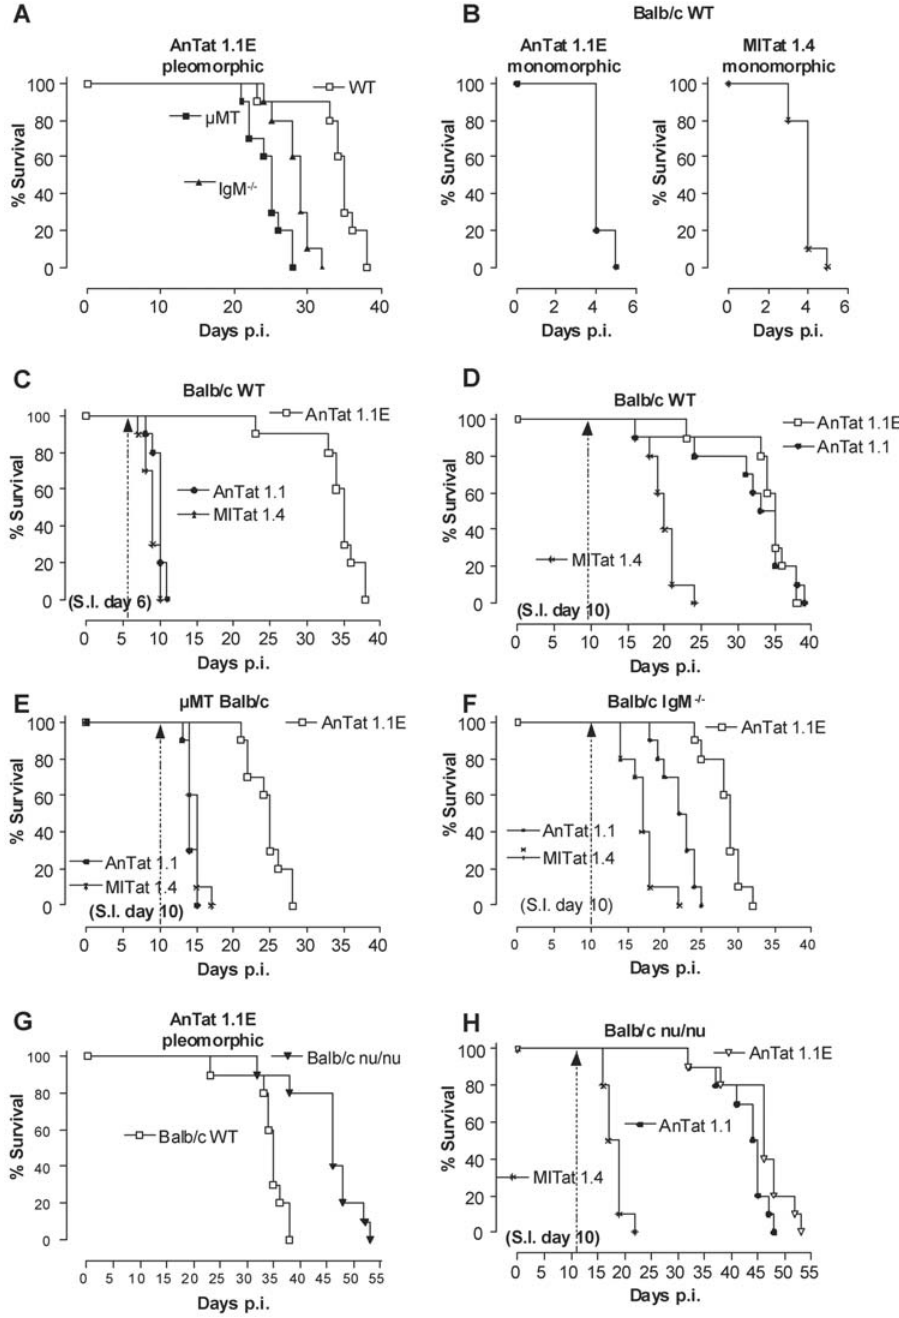
Figure 4. The role of IgM in VSG-specific protection. (A) BALB/c WT ( % ), IgM 2 / 2 ( m ) and m MT ( & ) mice were infected with 5000 pleomorphic AnTat 1.1E parasites. (B) BALB/c WT mice were infected with 5000 monomorphic AnTat 1.1 ( N ) or MITat 1.4 ( ) parasites. (C) AnTat 1.1E infected BALB/ c WT ( % ) mice were super-infected (S.I.) on day 6 or (D) on day 10 with 5000 parasites of a homologous, monomorphic AnTat 1.1 ( N ) or a non- homologous monomorphic, MITat 1.4 ( ) strain. (E) AnTat 1.1E infected BALB/c m MT ( % ) and (F) BALB/c IgM 2 / 2 ( % ) mice were super-infected with AnTat 1.1 ( N ) or MITat 1.4 ( ) parasites using the same strategy described above in C–D. (G) BALB/c WT ( % ) and BALB/c nu/nu ( . ) mice were infected with 5000 AnTat 1.1E parasites and (H) were super-infected AnTat 1.1 ( N ) or MITat 1.4 ( ) parasites using the same strategy described above in C–D. All primary and super-infections were done by intra-peritoneal inoculation of 5000 parasites. Mortality was recorded using 10 mice per experimental group and the results were compared to mice that only received the primary infection. One out of 3 representative experiments is shown. doi:10.1371/journal.ppat.1000122.g004 (M.S. = 18 days) as compared to control WT and AnTat 1.1 in m MT mice (Fig. 4E) which displayed a mean survival of 15 days. This was not unexpected since both monomorphic parasites killed infected mice (M.S.= 34 days for both groups) (Fig. 4D). However, the observed host killing occurred with slower kinetics than WT mice within 4–5 days (Fig. 4B). VSG-specific resistance in observed in Fig. 4B. VSG-specific resistance at day 10 was absent IgM 2 / 2 mice re-challenged at the same time point with the same